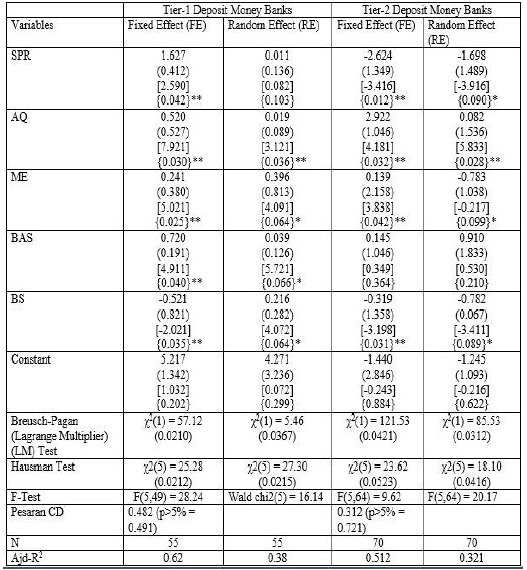
Table 2: Panel Result for Objective of the Study